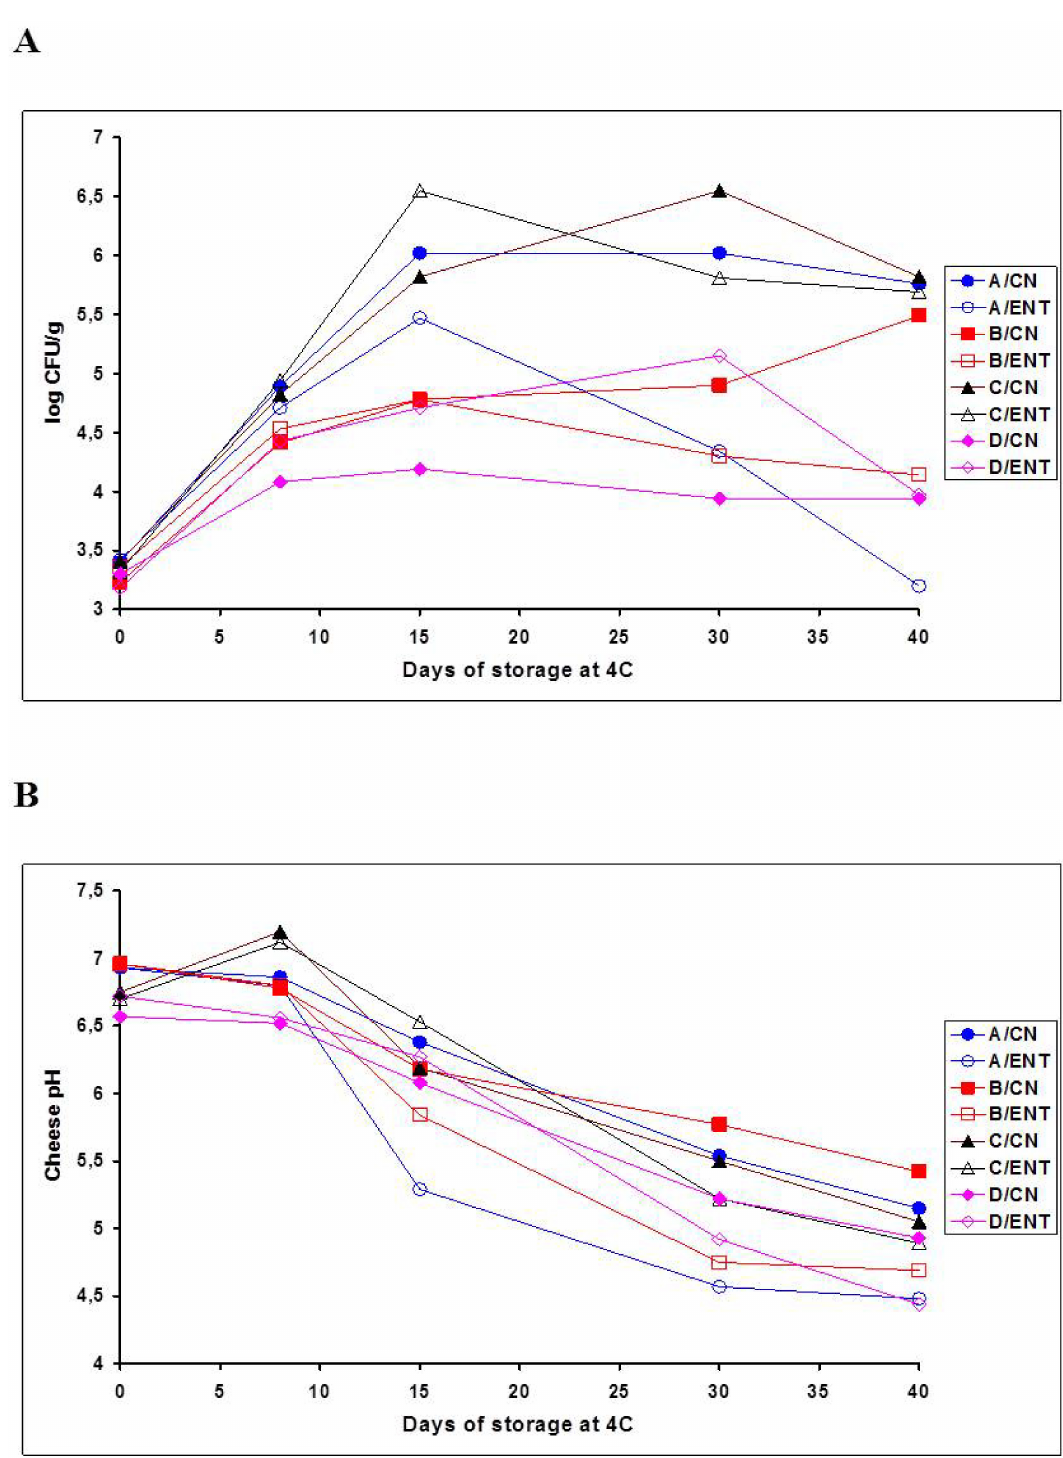
Figure 1. Cheese batch-dependent growth and survival of Listeria monocytogenes ( A ) in association with the pH changes ( B ) during refrigerated (4 ◦ C), vacuum-packed storage of four batches (A, B, C and D) of fresh Greek Anthotyros whey cheeses without (CN) or with 5% (v/w ) of an added crude enterocin A-B-P extract (ENT). The pH data in Figure 1B were adapted from Table S1 [37]. In summary, the growth of L. monocytogenes was not fully controlled in any of the fresh whey cheese products studied. Indeed, from its lowest population after inoculation (day 0) to its highest batch-dependent population on day 15, or 30 or 40, the total